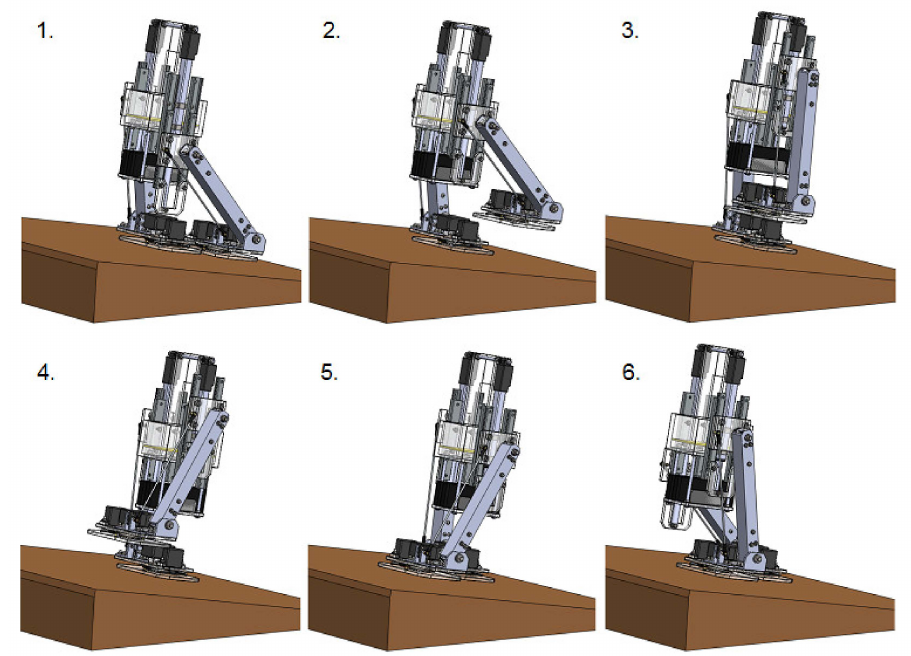
Figure 20. Snapshots sequence from a step simulation of a pad with an 8 ◦ uphill slope. Legends: 1—the center of gravity of the robot is above the right foot; 2—the left linear actuator performs